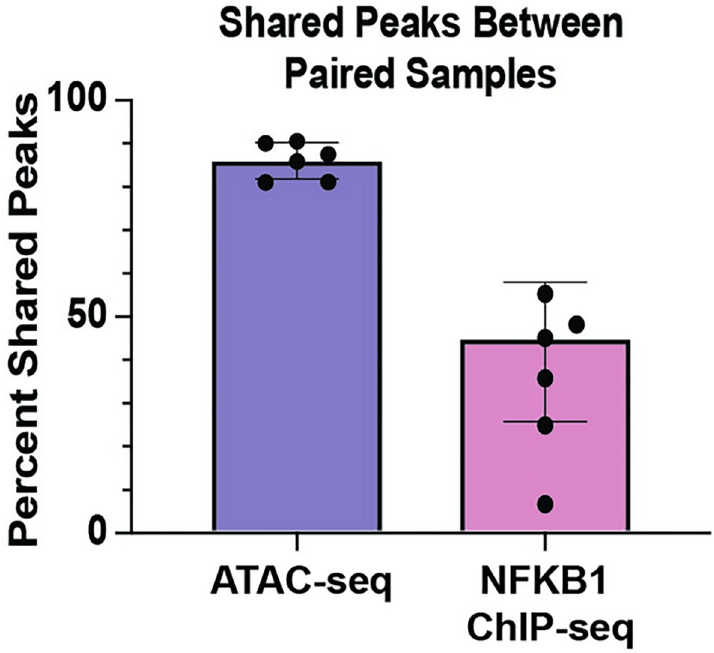
Fig 3. Shared peaks in ATAC-seq and chromatin immunoprecipitation with sequencing (ChIP-seq) experiments between paired subjects. Percentage of shared peaks between paired samples in ATAC-seq compared to NFKB1 ChIP-seq